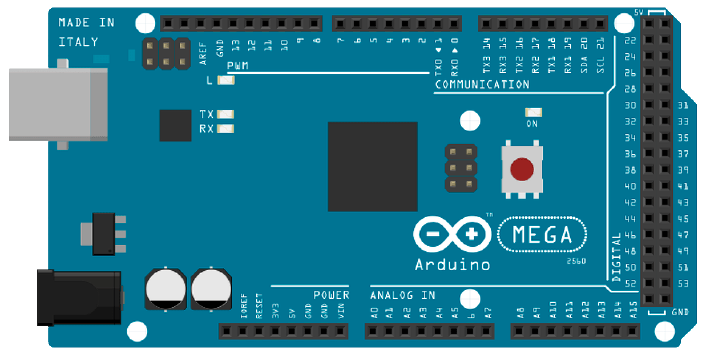
Figure 8. The Arduino